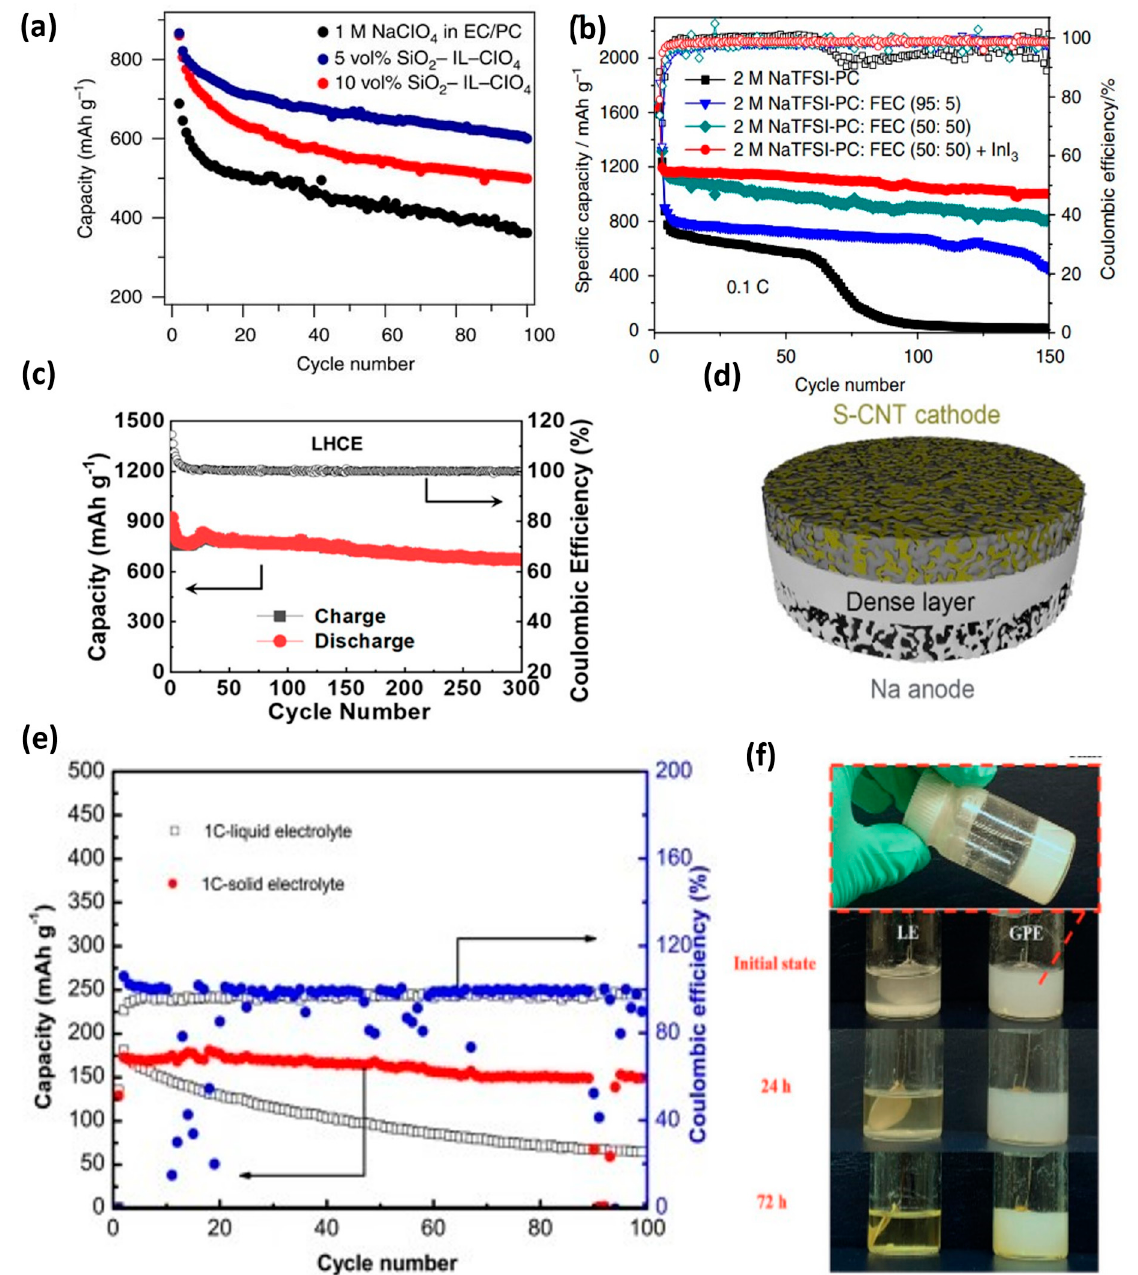
Figure 7. ( a ) Cycle performance of RT − NaSBs with a tailored SiO 2 –IL–ClO 4 electrolyte with